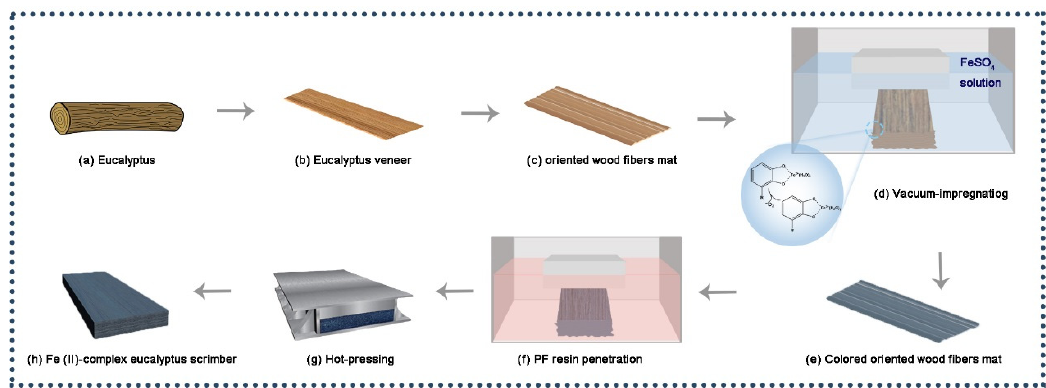
Figure 1. Preparation process of Fe (II)–complex wood scrimber ( a – h ).